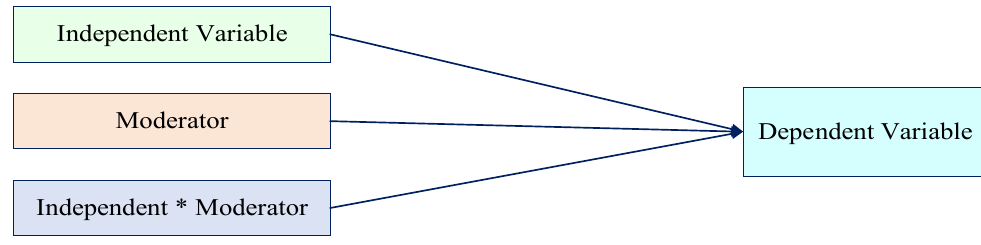
Figure 4. Statistical moderation model adapted from Awang